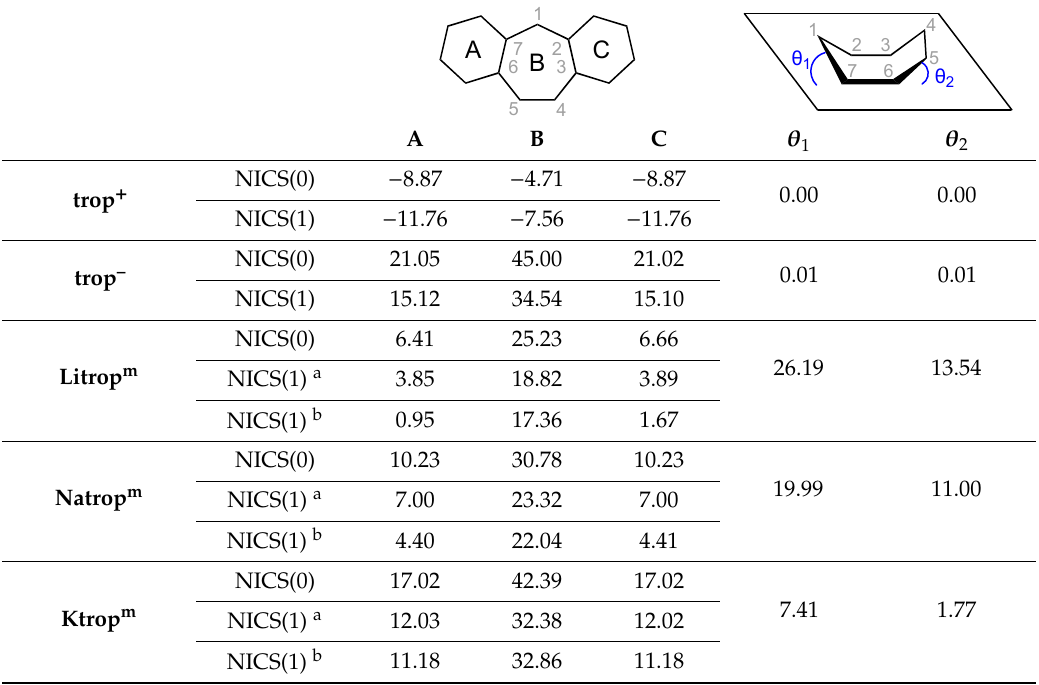
Table 5. Calculated isotropic NICS(0) and NICS(1) values for trop + , trop ‒ , model compounds Mtrop m (M = Li, Na, K) and K 2 trop m , [Rh(trop)(cod)] and cyclobutadiene (CBD). The model compounds do not contain solvent molecules attached to the alkali cations. Computational details: PBE [38,39] 6-311+G(df, pd) [40] in a continuum solvation model (THF). Abbreviations: θ 1 and θ 2 : dihedral angles of the optimized structures (°), CBD: 1,3-cyclobutadiene.